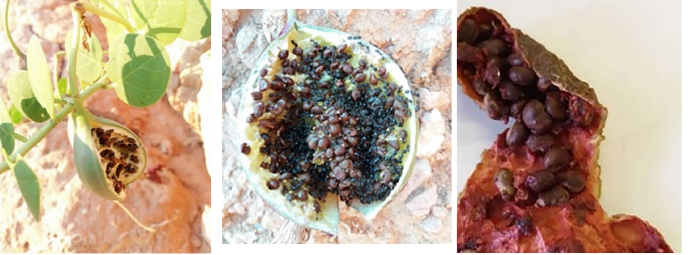
Figure 8. (Left) Mature dehiscent fruit of Capparis spinosa ; (center) half of a caper fruit with seeds and ants (magnified × 5); (right) part of the sticky fruit endocarp with adhered seeds (magnified ×